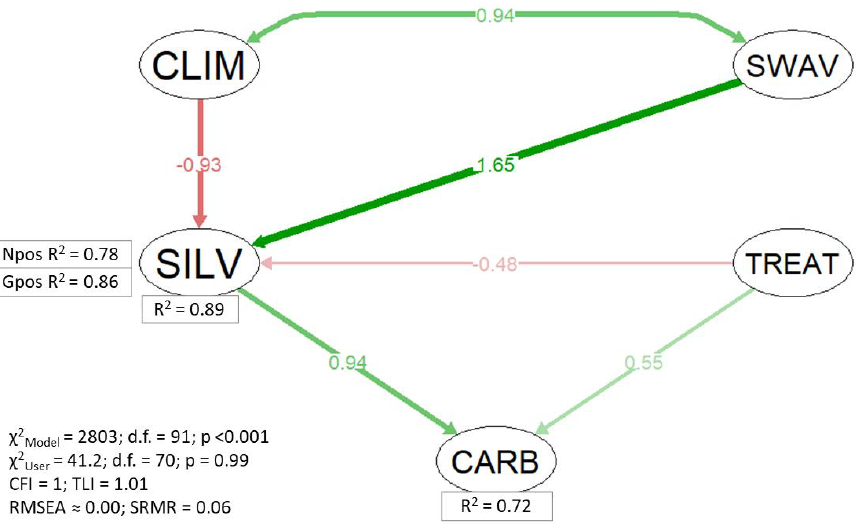
Figure 3. Structural Equation Model path describing the effects of multiple predictors in carbon stock and dasometric variables after treatments. Only significant effects or covariances were showed. Nodes represent different categories of predictors and endogenous variables: CLIM = Climatic variables; SWAV = Soil water availability; TREAT = Treatment variables; SILV = Silvicultural status of forest after treatment; CARB = SOC 10 . The ellipsoid of CARB does not represent a latent variable. Boxes represent the R 2 values for the explained variance of dependent variables. Red arrows mean negative effect. Green arrows mean positive effect. Double-headed pivot arrows mean covariance between groups of variables. Arrow labels show standardized effects magnitude. χ 2 Model represents the parameters for the model fit, and χ 2 User represents the parameters for the comparison between variances of the model and the